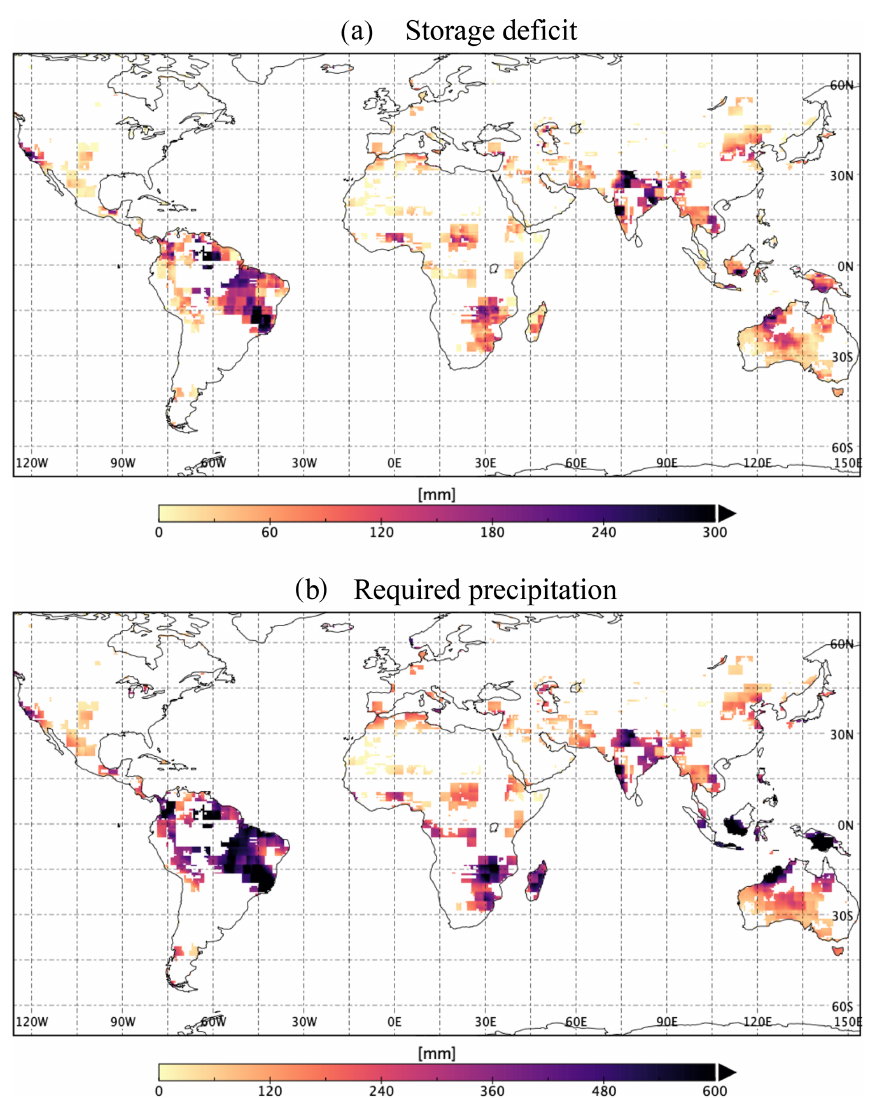
Figure 7. (a) Storage deficit in an example month (January 2016). (b) The amount of required precipitation to fill the